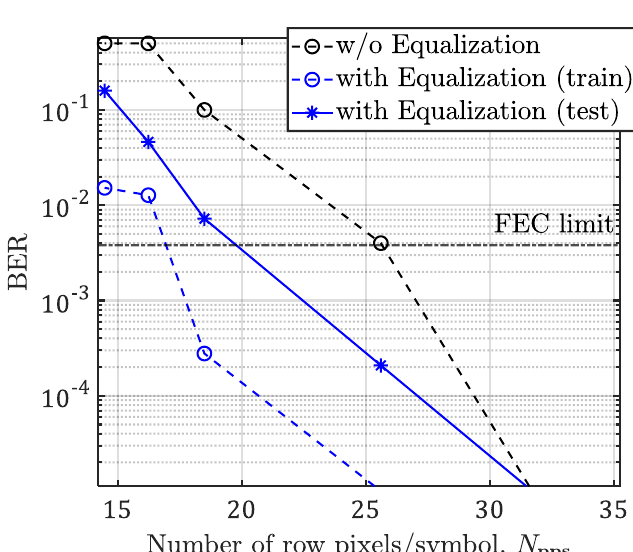
Figure 11. The BER measurements as a function of 𝑁 pps for the proposed system with and without equalization and for T exp of 2 ms. equalization and for T exp of 2 ms. Table 4. Effective R b at different ISs resolutions at the FEC limits.